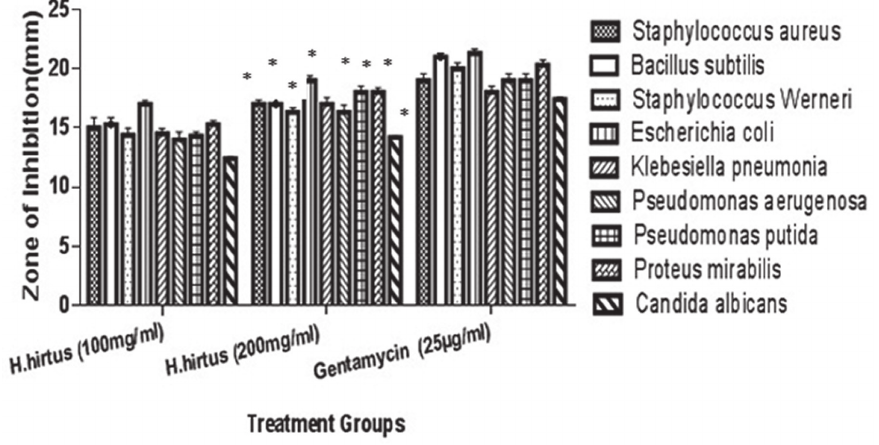
FIGURE 5 - Zone of inhibition of Hibiscus hirtus ethanolic